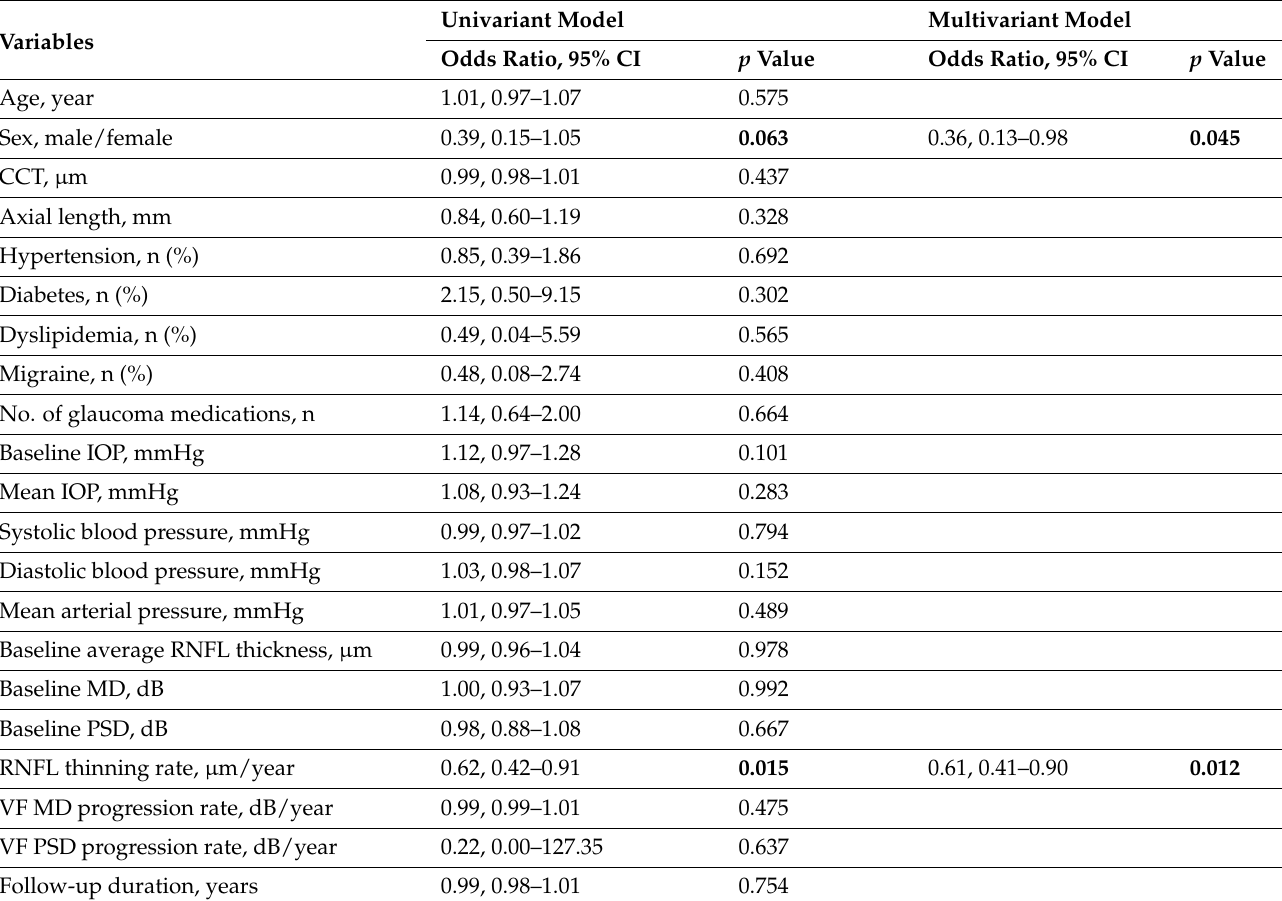
Table 3. Logistic regression testing factors associated with the presence of pseudoexfoliation